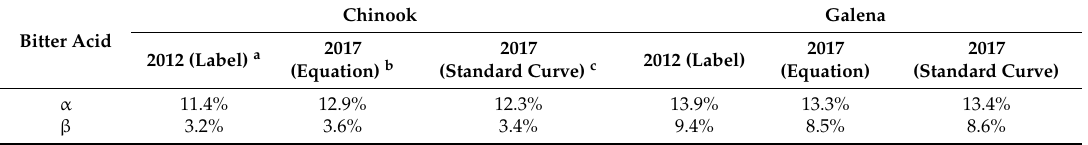
Table 1. α - and β -acid concentrations of Chinook and Galena hop pellets as given on the label (Label), determined by the ASBC equation (Section 2.2), or determined by a linear equation (Equation) generated with an 8-point standard curve (Standard Curve). Values are from 3 pooled extractions, and are given on a dry matter